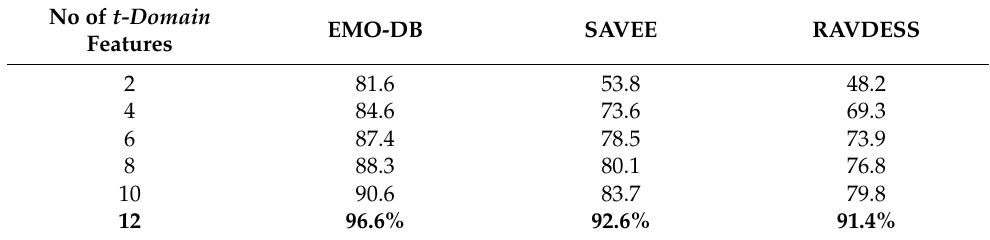
Table 4. t-domain features used to obtain MFCCT features.